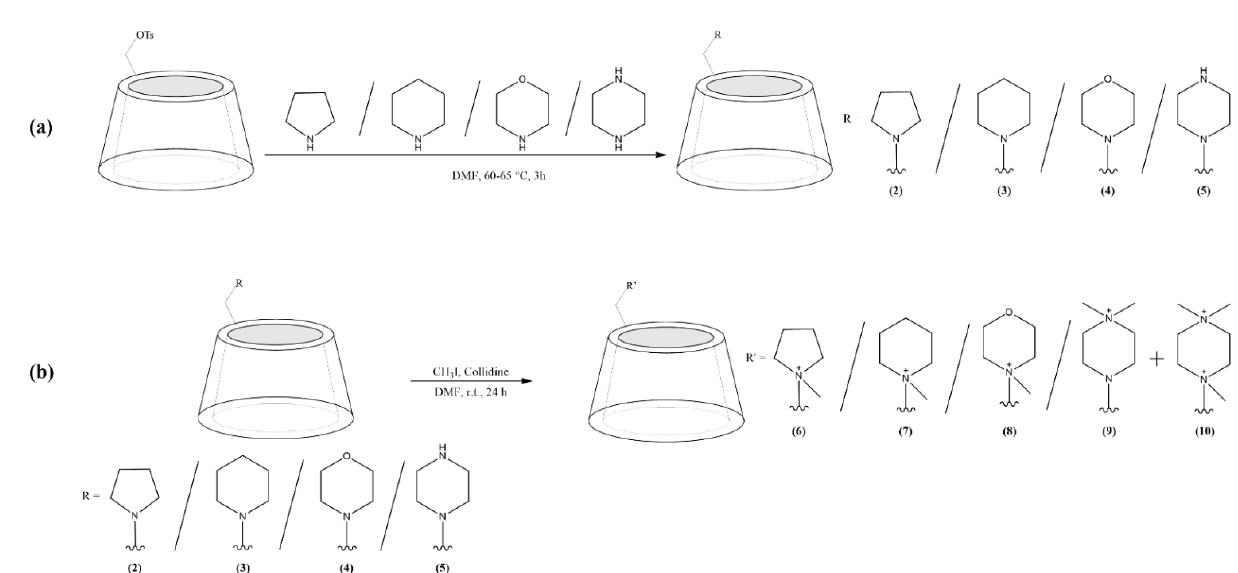
Figure 1. Synthetic schemes and structures of the N -heterocycle-substituted β -CD derivatives. ( a ) pH-adjustable derivatives: mono-(6- N -pyrrolidine-6-deoxy)- β -CD (PYR- β -CD) ( 2 ), mono-(6- N -piperidine-6-deoxy)- β -CD (PIP- β -CD) ( 3 ), mono-(6- N -morpholine-6-deoxy)- β -CD (MO- β -CD) ( 4 ), mono-(6- N -piperazine-6-deoxy)- β -CD (PIPA- β -CD) ( 5 ) and ( b ) perma- nently cationic derivatives: mono-(6- N -( N -methyl-pyrrolidine)-6-deoxy)- β -CD (MePYR- β -CD) ( 6 ), mono-(6- N -( N -methyl- piperidine)-6-deoxy)- β -CD (MePIP- β -CD) ( 7 ), mono-(6- N -( N -methyl-morpholine)-6-deoxy)- β -CD (MeMO- β -CD) ( 8 ), mono- (6- N -(4,4- N,N -dimethyl-piperazine)- β -CD (diMePIPA- β -CD) ( 9 ). The compounds 2-5 in ( b ) are the same as that in ( a ).